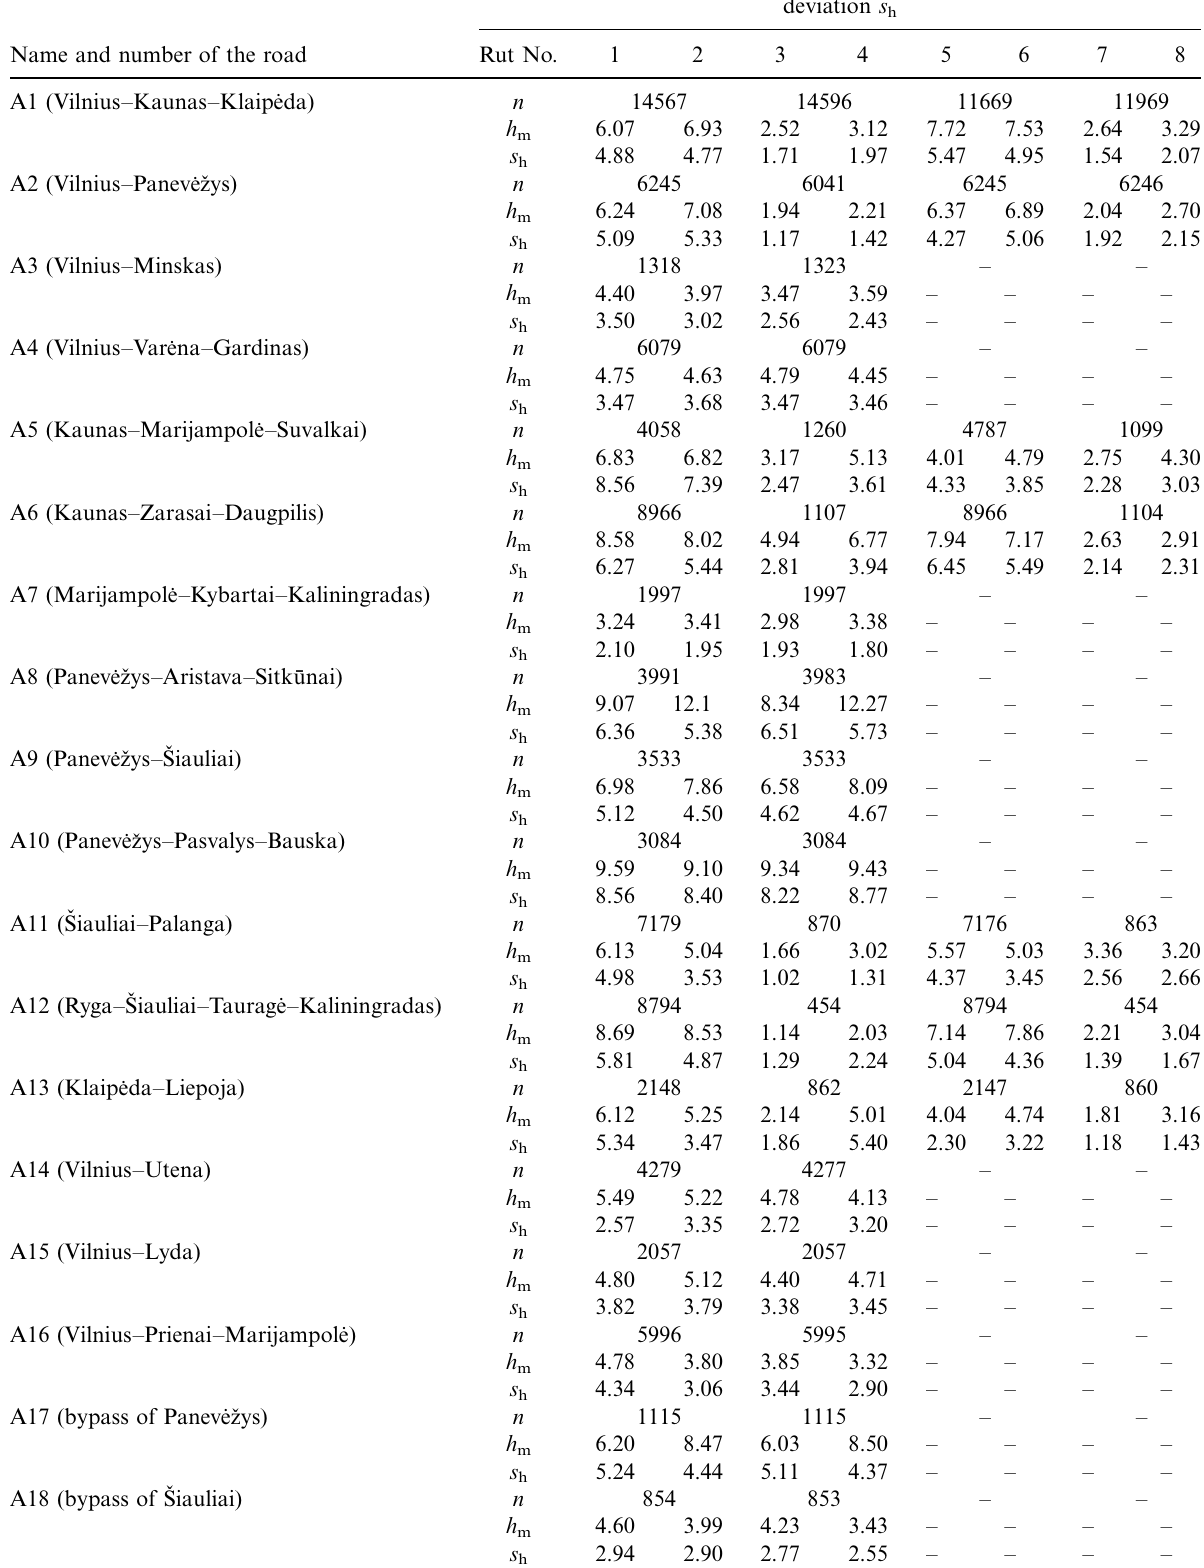
Rutting measured every 20 m, number of readings n , mean h m , standard deviation s h